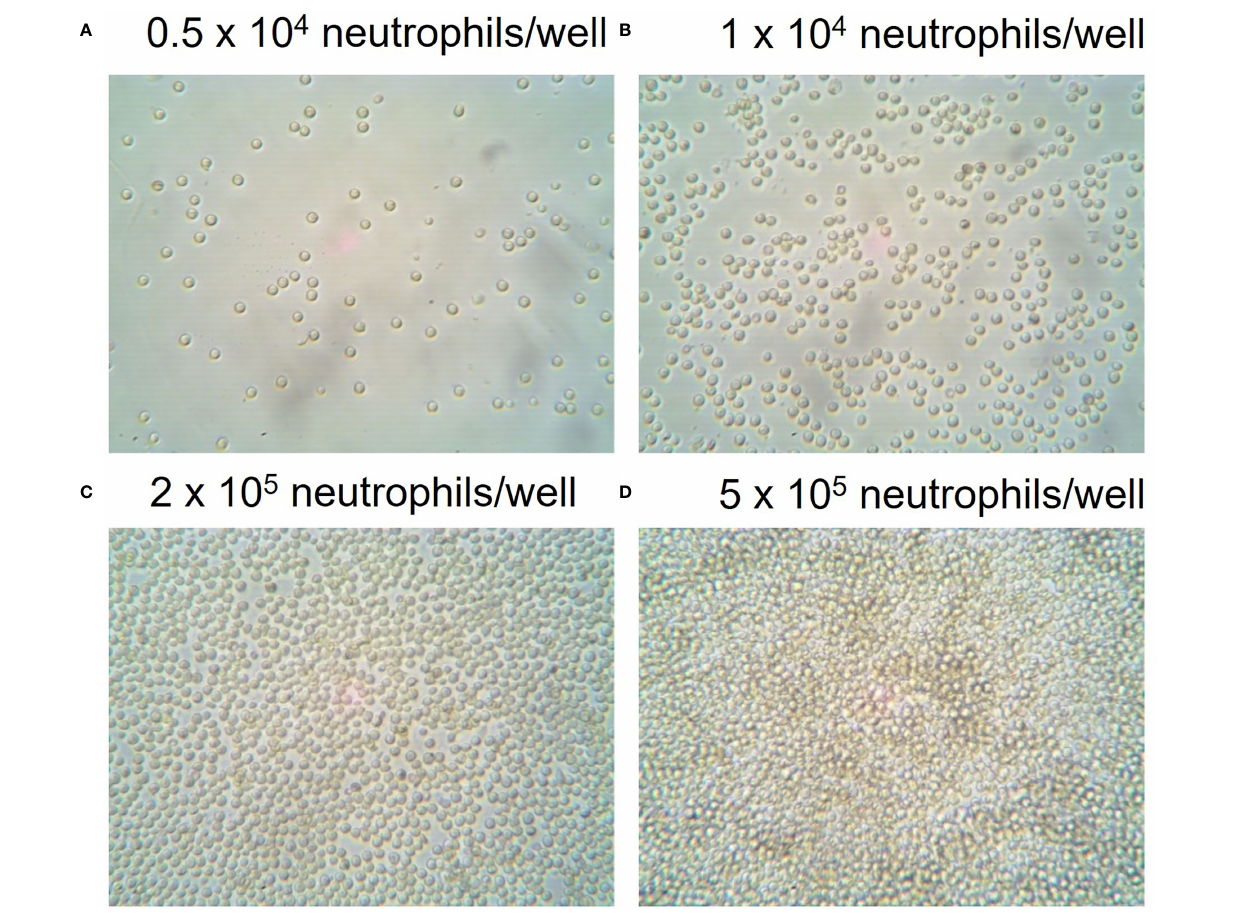
FIGURE 1 Seeding densities of neutrophils in XFe96 coated microplates. Human peripheral blood neutrophils were isolated from whole blood of donors before seeding into Cell-Tak ™ coated XFe96 cell culture plates at (A) 1 x 10 4 , (B) 5 x 10 4 , (C) 2 x 10 5 or (D) 5 x 10 5 /well. XFe96 cell culture microplates containing neutrophils were imaged under an inverted light microscope (45x magni fi cation) and examined by eye for con fl uence